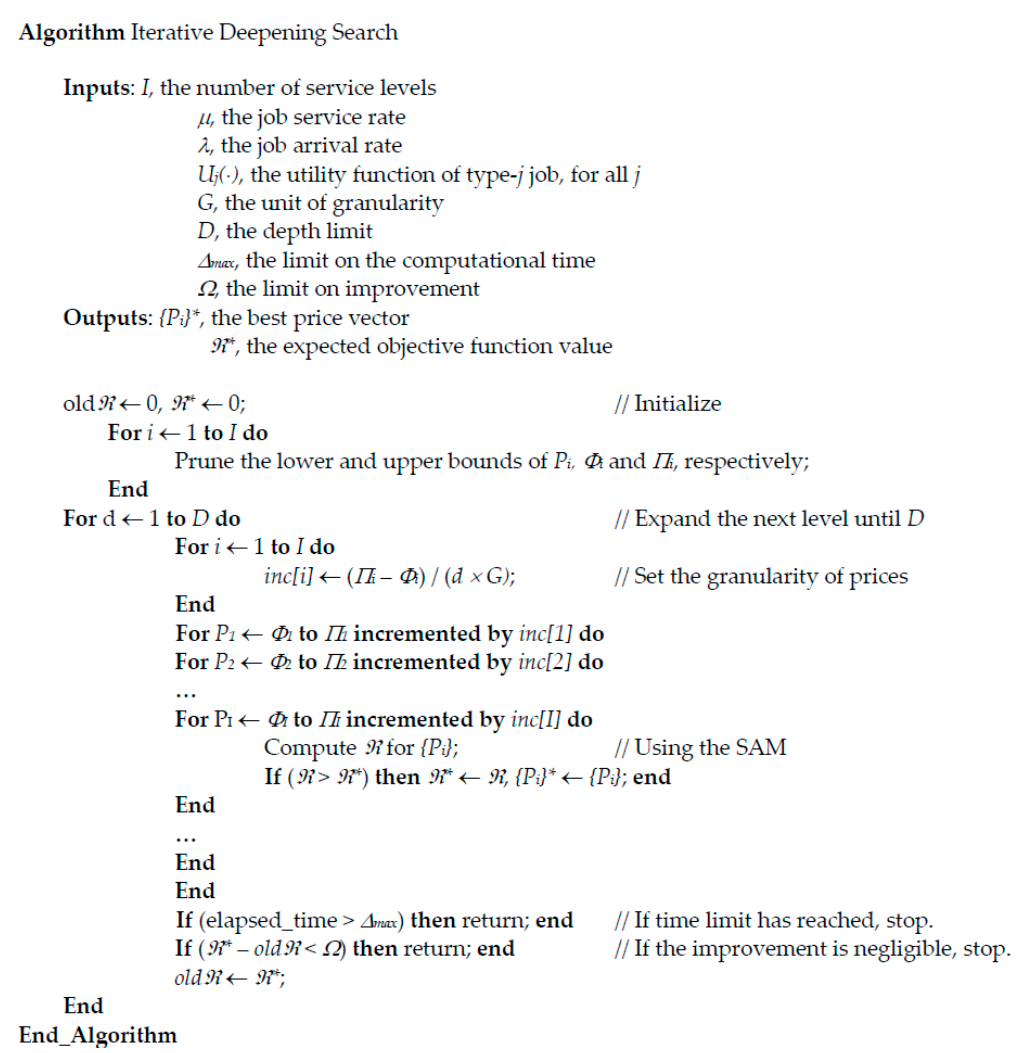
Figure 7. Iterative deepening search algorithm.